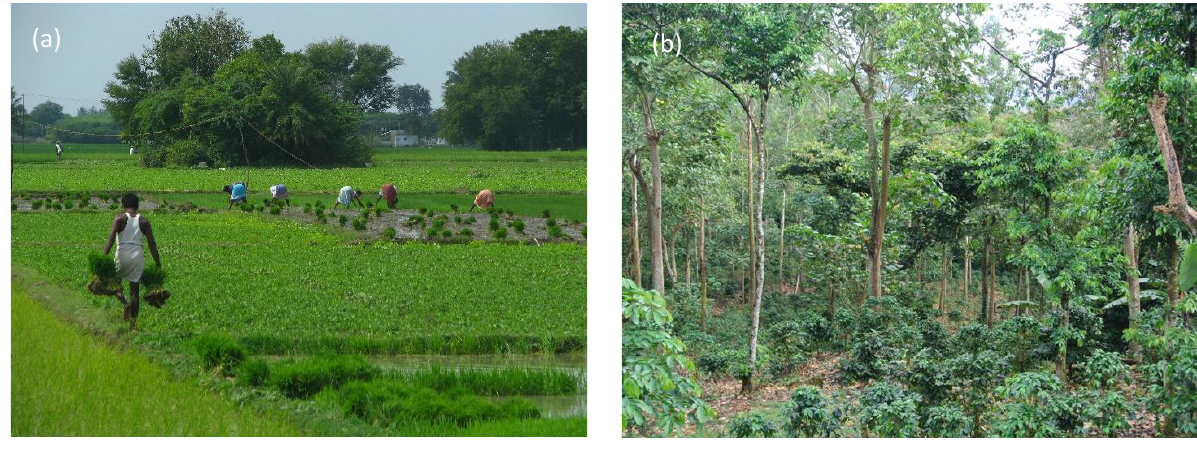
Figure A1.1: Photographs used to illustrate the (a) current and (b) the envisioned state of the land. These photographs were shown along with a detailed explanation of the kind of agroforestry practices that the landowner could potentially undertake. Photographs are for representation purpose